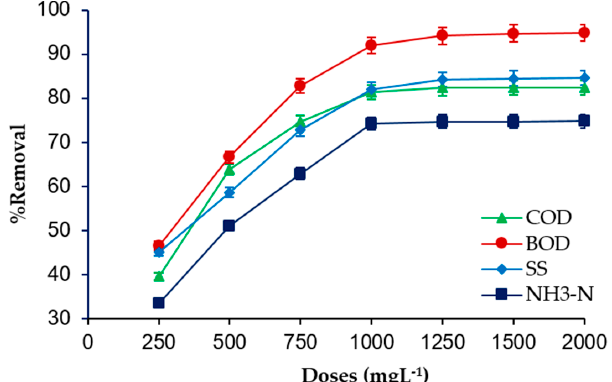
Figure 2. Influence of coagulant doses on the removal of COD, BOD, SS, and NH 3 from SRPE using FeSO 4 · 7H 2 O as a coagulant. pH 5, coagulation time of 60 min, and sedimentation time of 60